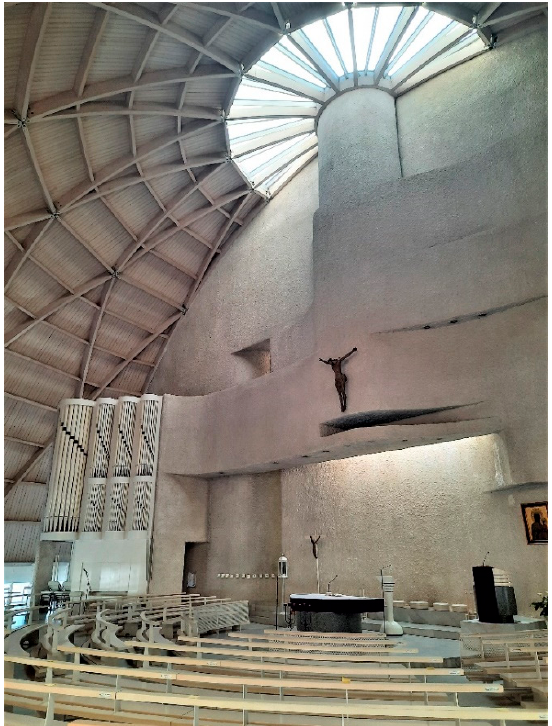
Figure 5. View of the semicircular main hall with the complex concrete wall. Above the altar, the oculus both physically and symbolically illuminates the assembly.